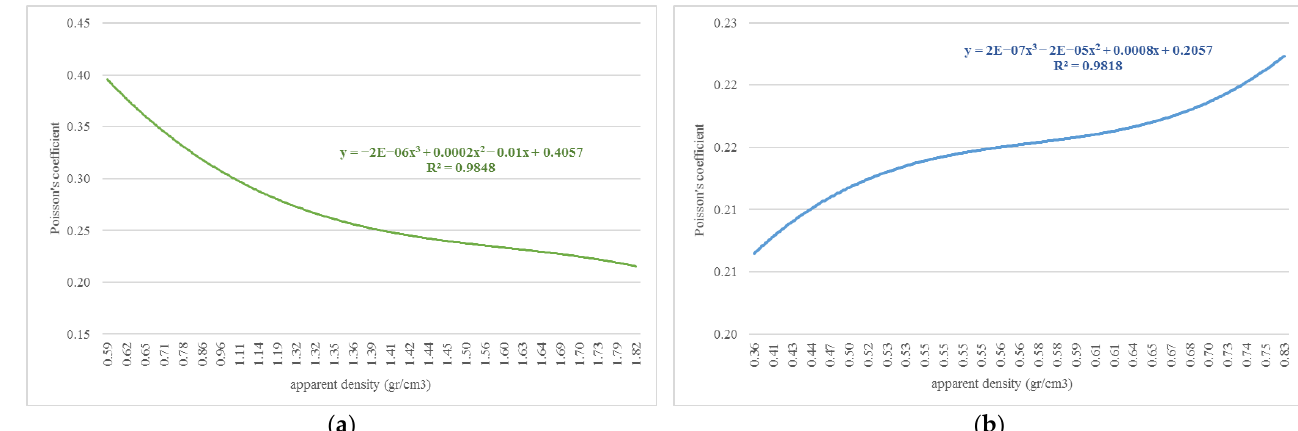
Figure 7. Relationship between apparent density and Poisson’s coefficient for bone tissue affected with OI: ( a ) cortical tissue; ( b ) trabecular tissue.